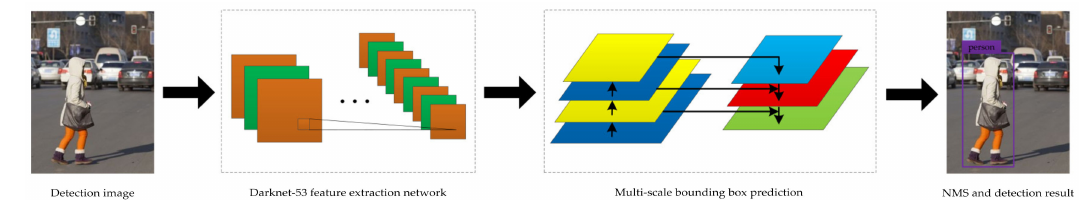
Figure 1. The schematic diagram of the detection process using